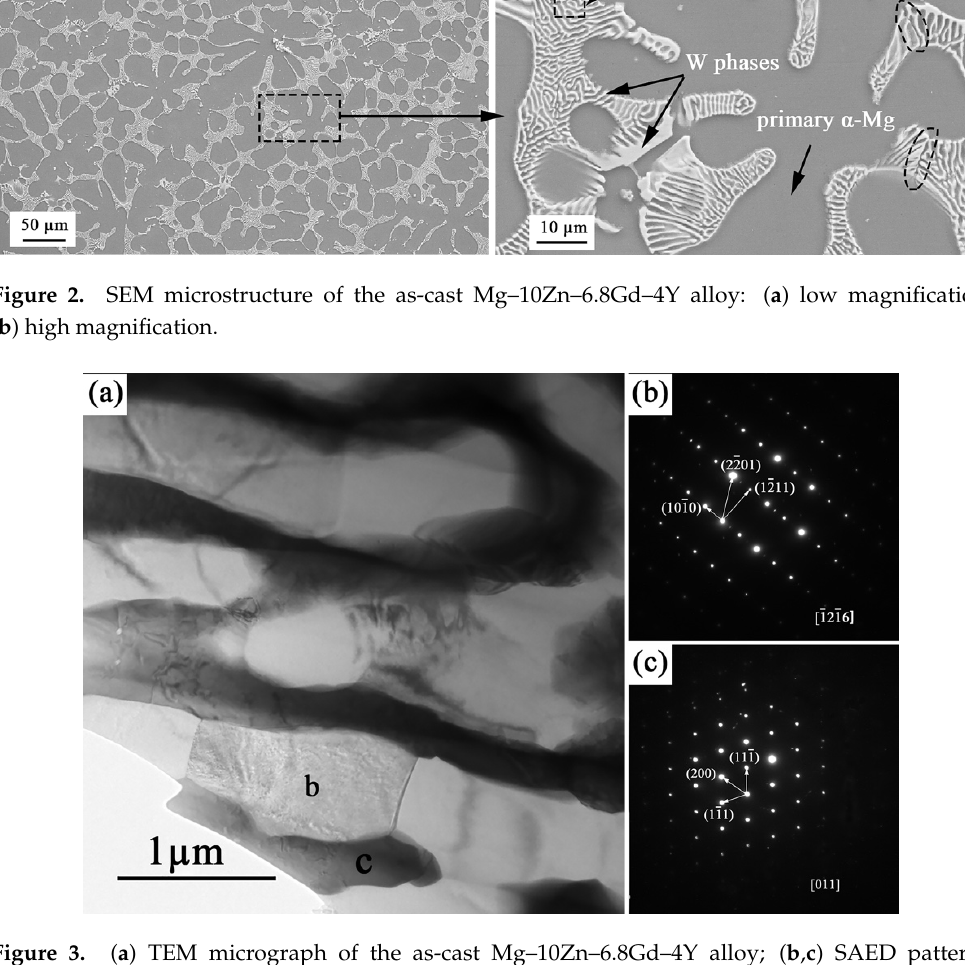
Figure 3. ( a ) TEM micrograph of the as-cast Mg–10Zn–6.8Gd–4Y alloy; ( b ), ( c ) SAED patterns corresponding to regions b and c.